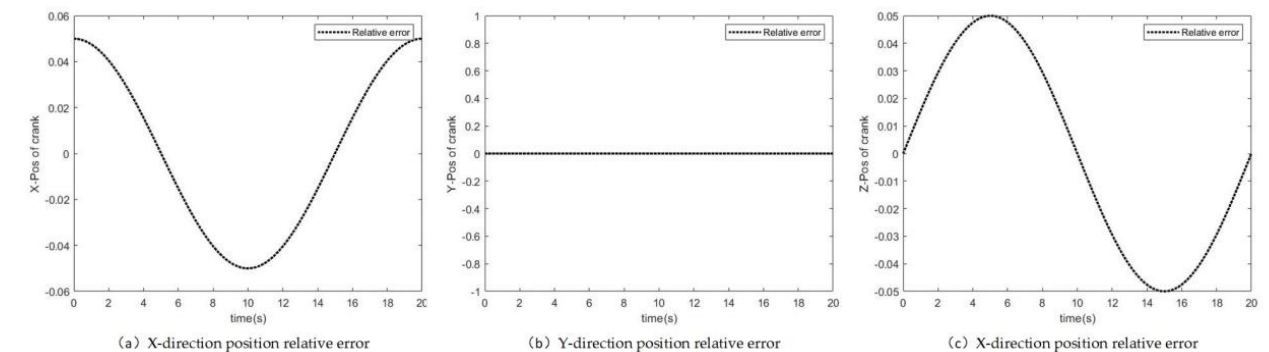
Figure 5. Relative displacement difference of connecting rod joint.